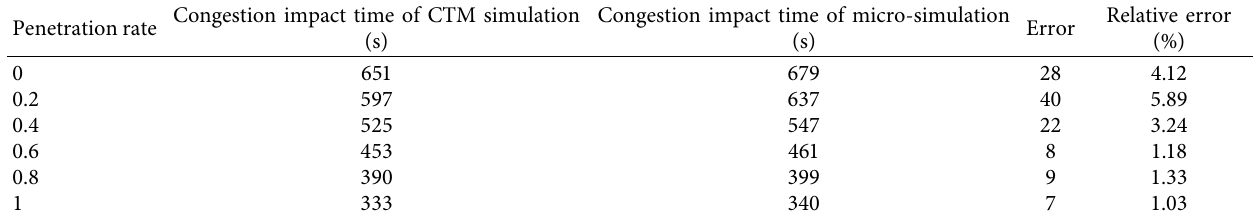
Table 3: Comparison of simulation results under two simulation